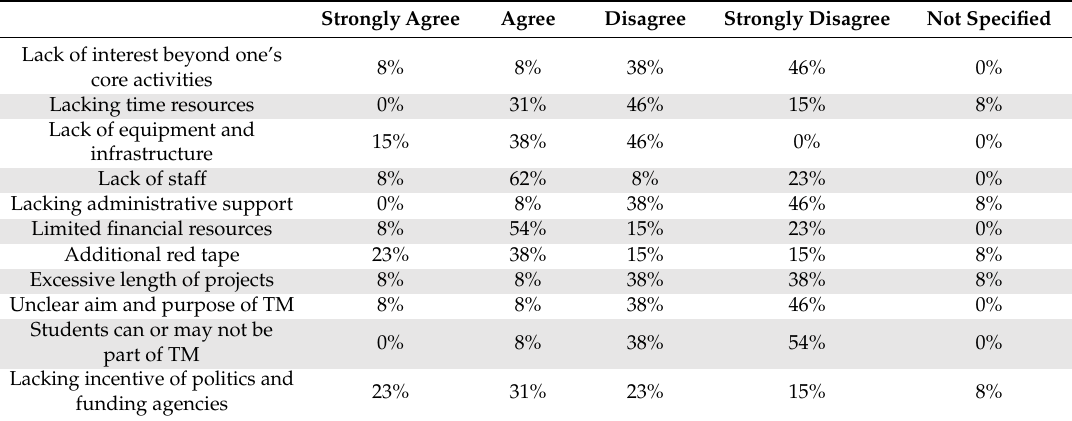
Table 2. Negative impact factors on TM